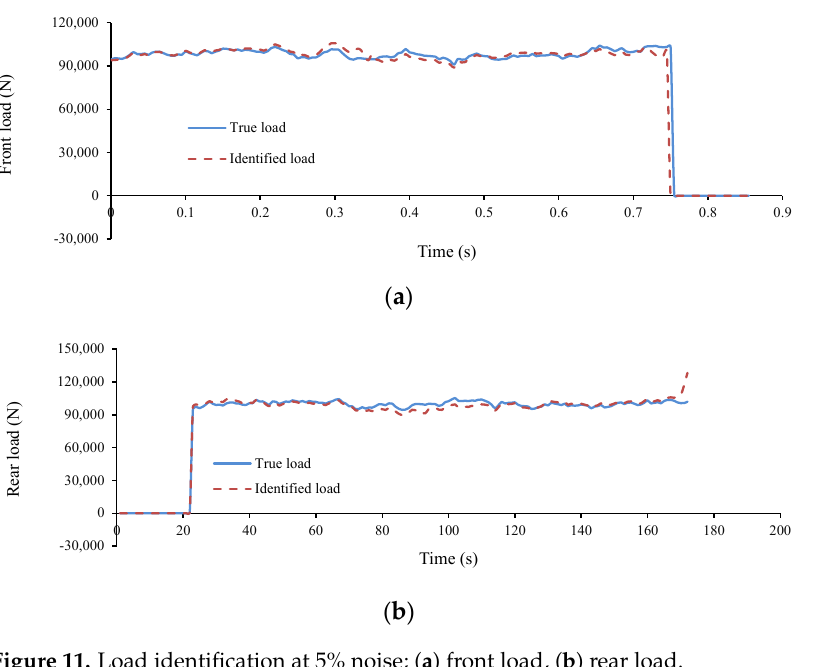
Figure 11. Load identification at 5% noise; ( a ) front load, ( b ) rear load.